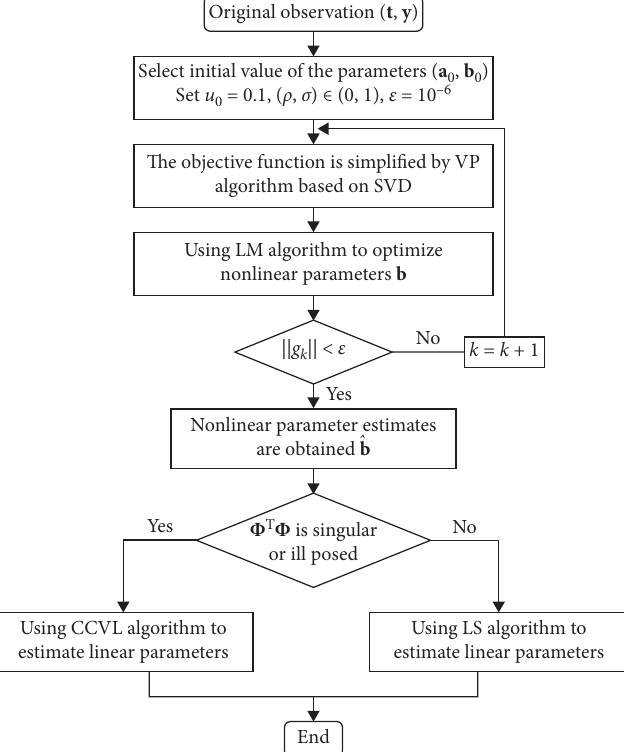
Figure 1: Flowchart for the parameter estimation